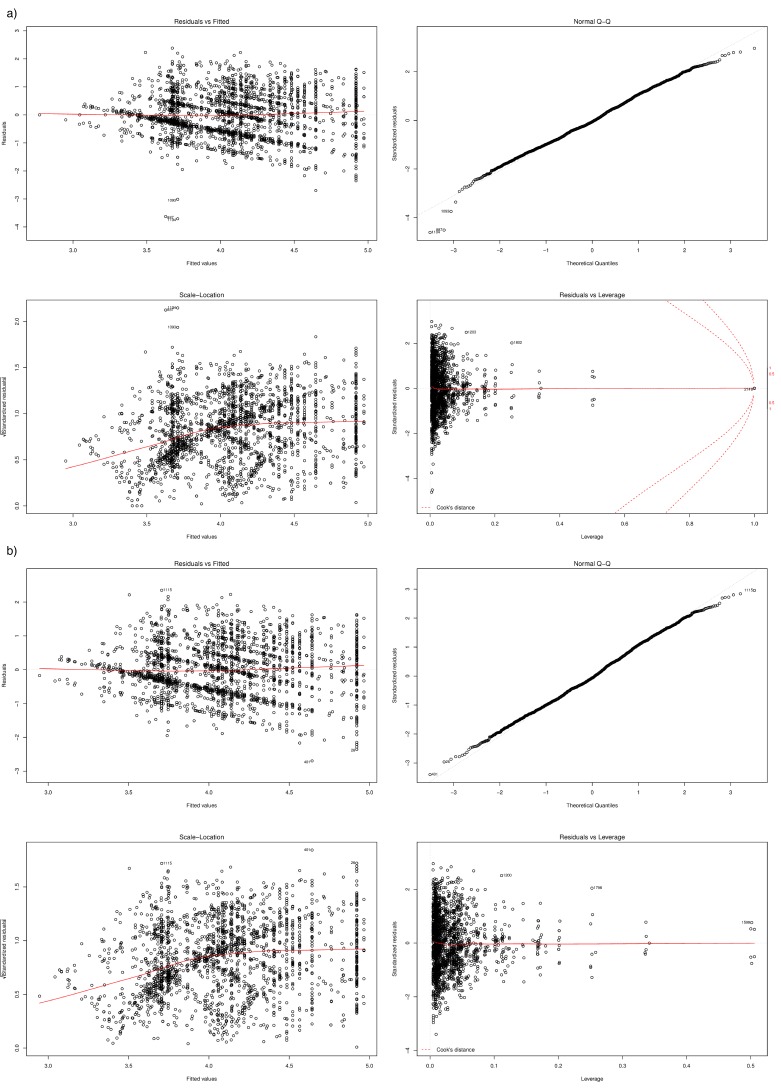
Regression diagnostics and outlier removal.Panel (a) shows prior to outlier removal, (b) after outlier removal as produced by plot.lm() in R. Points deviating from normal residuals (top right plot), and at high leverage (bottom right plot) were removed. These observations appeared to be due to swabs not taken at the prescribed monthly intervals.